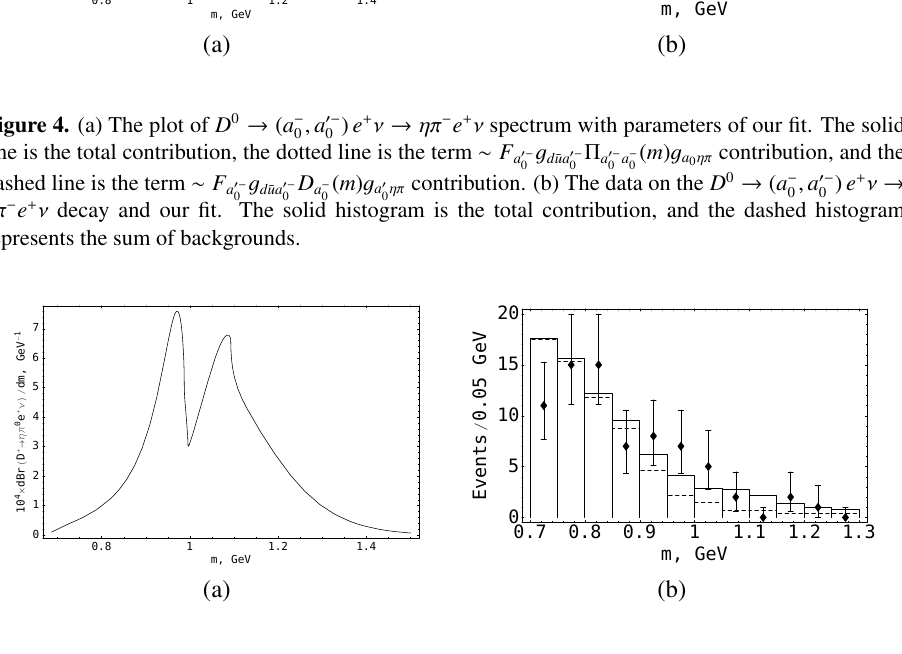
, a (cid:48) 0 ) e + ν → ηπ 0 e + ν decay with parameters of our fit. (b) 0 0 , a (cid:48) 0 ) e + ν → ηπ 0 e + ν decay. The solid histogram is the total contribution, 0 0